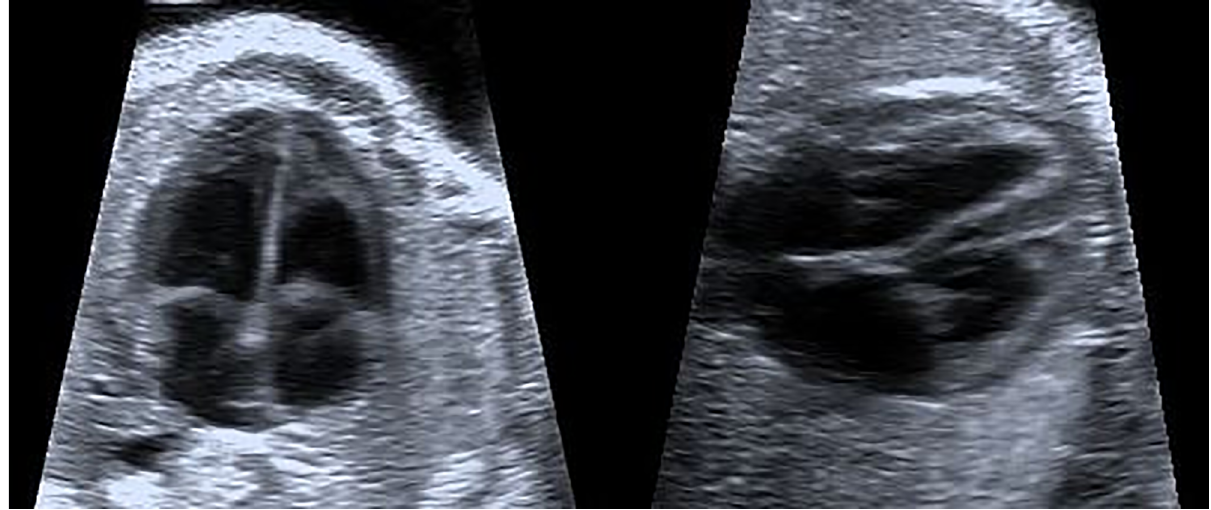
Fig 4. Example of a four chamber view of a fetal heart in longitudinal or apical (left) and transverse (right) section. Note that the interventricular septum and especially the thin interatrial septum are displayed best in the “in plane-view” of the transverse view where the ultrasound waves meet those structures